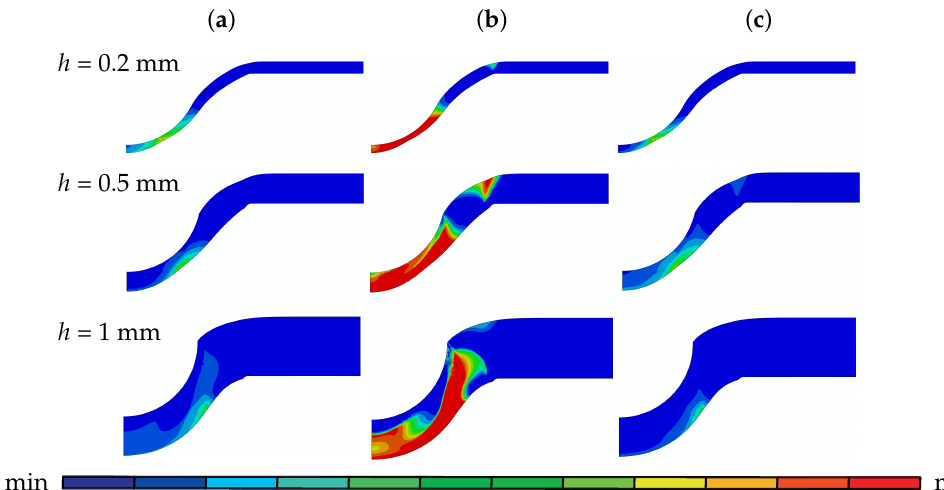
Figure 7. Damage plots ( a ) f ( b ) f n ( c ) f g of disks with 0.2 mm , 0.5 mm and 1 mm thickness before crack initiation: for h = 0.2 mm ( a ) [max 1.29 × 10 − 1 ; min 2.30 × 10 − 4 ], ( b ) [max 2.00 × 10 − 2 ; min